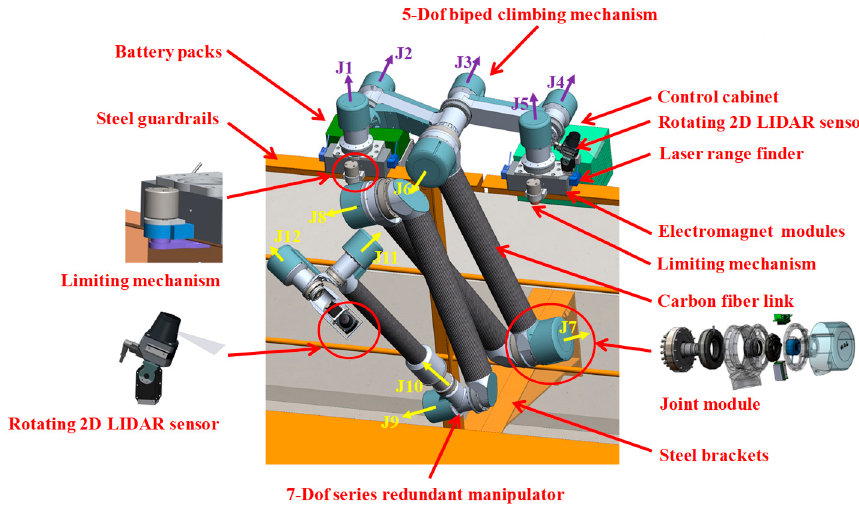
Figure 2. Overall structure of the climbing manipulator robot (CMBOT).